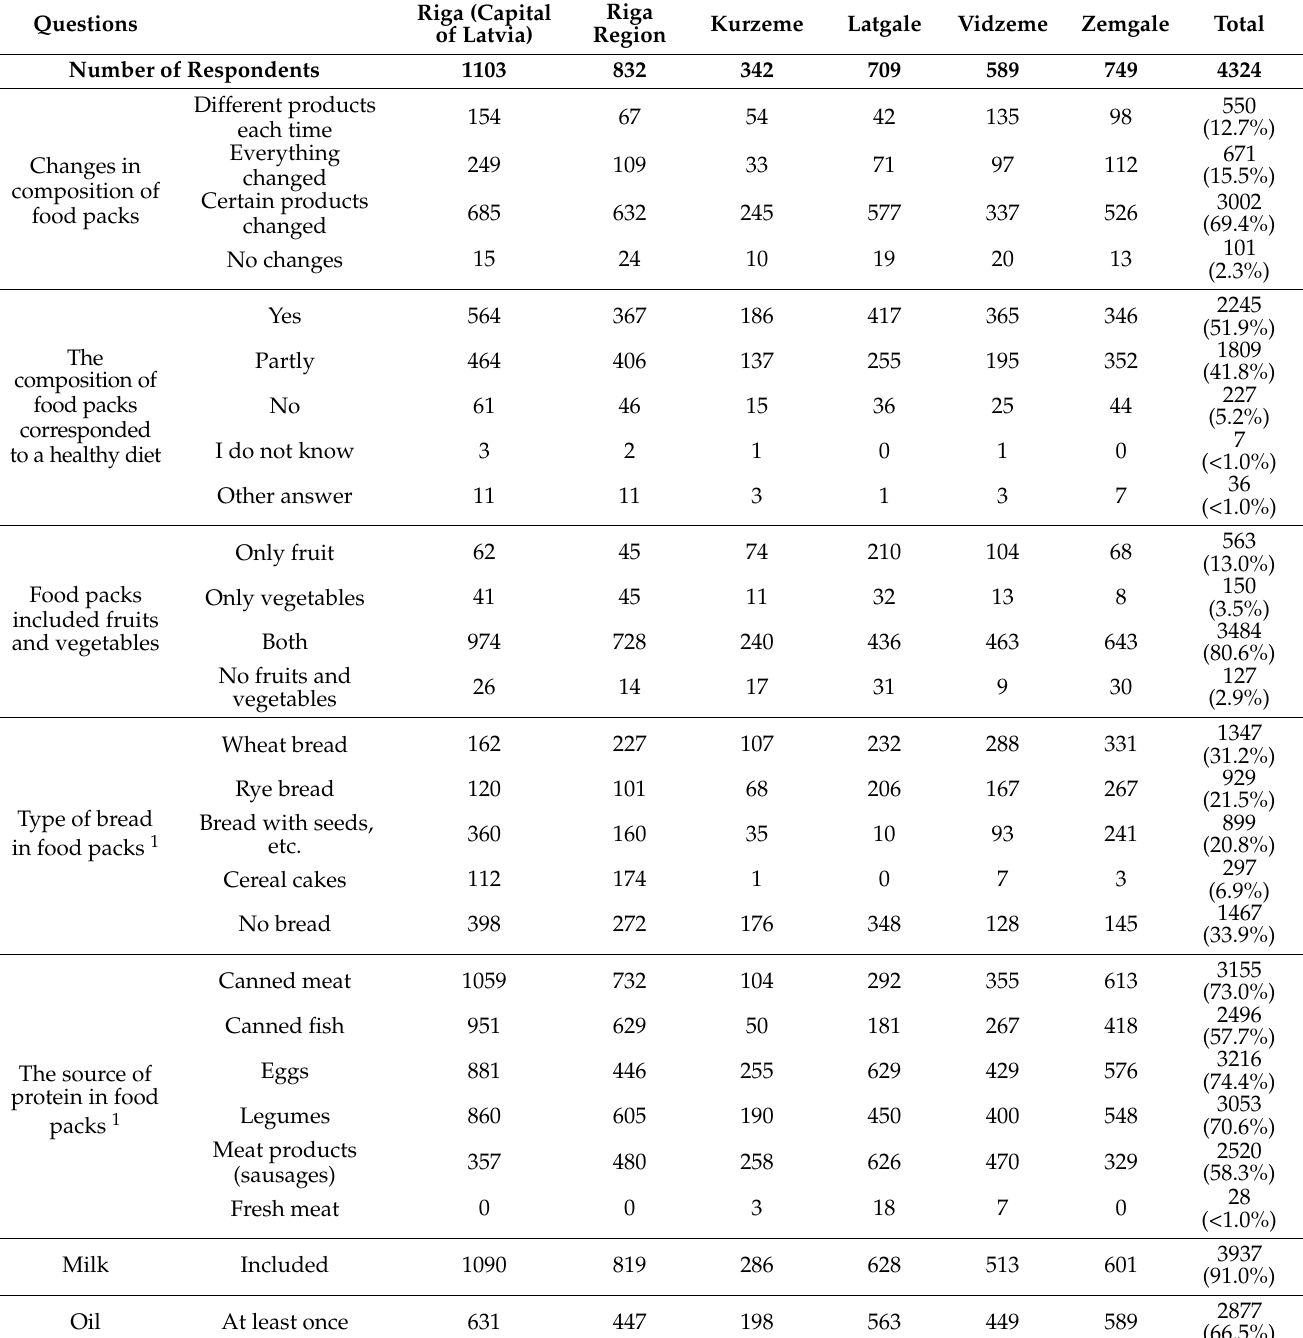
Table 3. Parental assessment of food packs by regions of